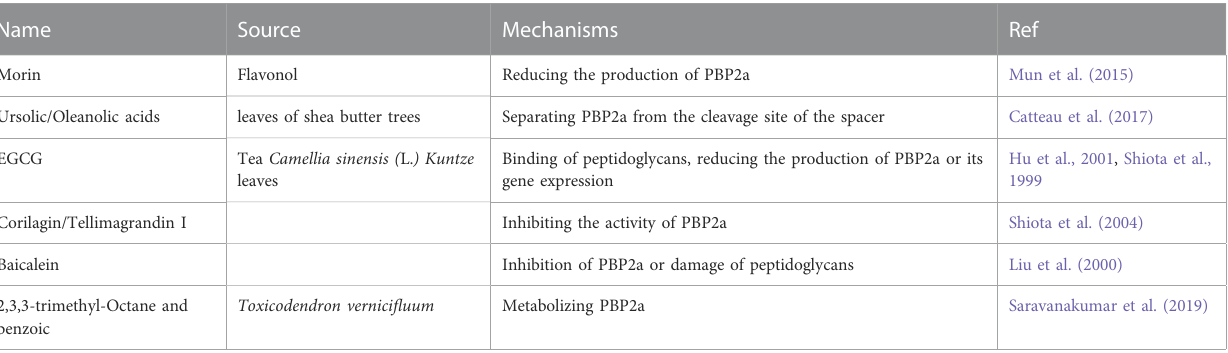
TABLE 4 The compounds from natural products that inhibit